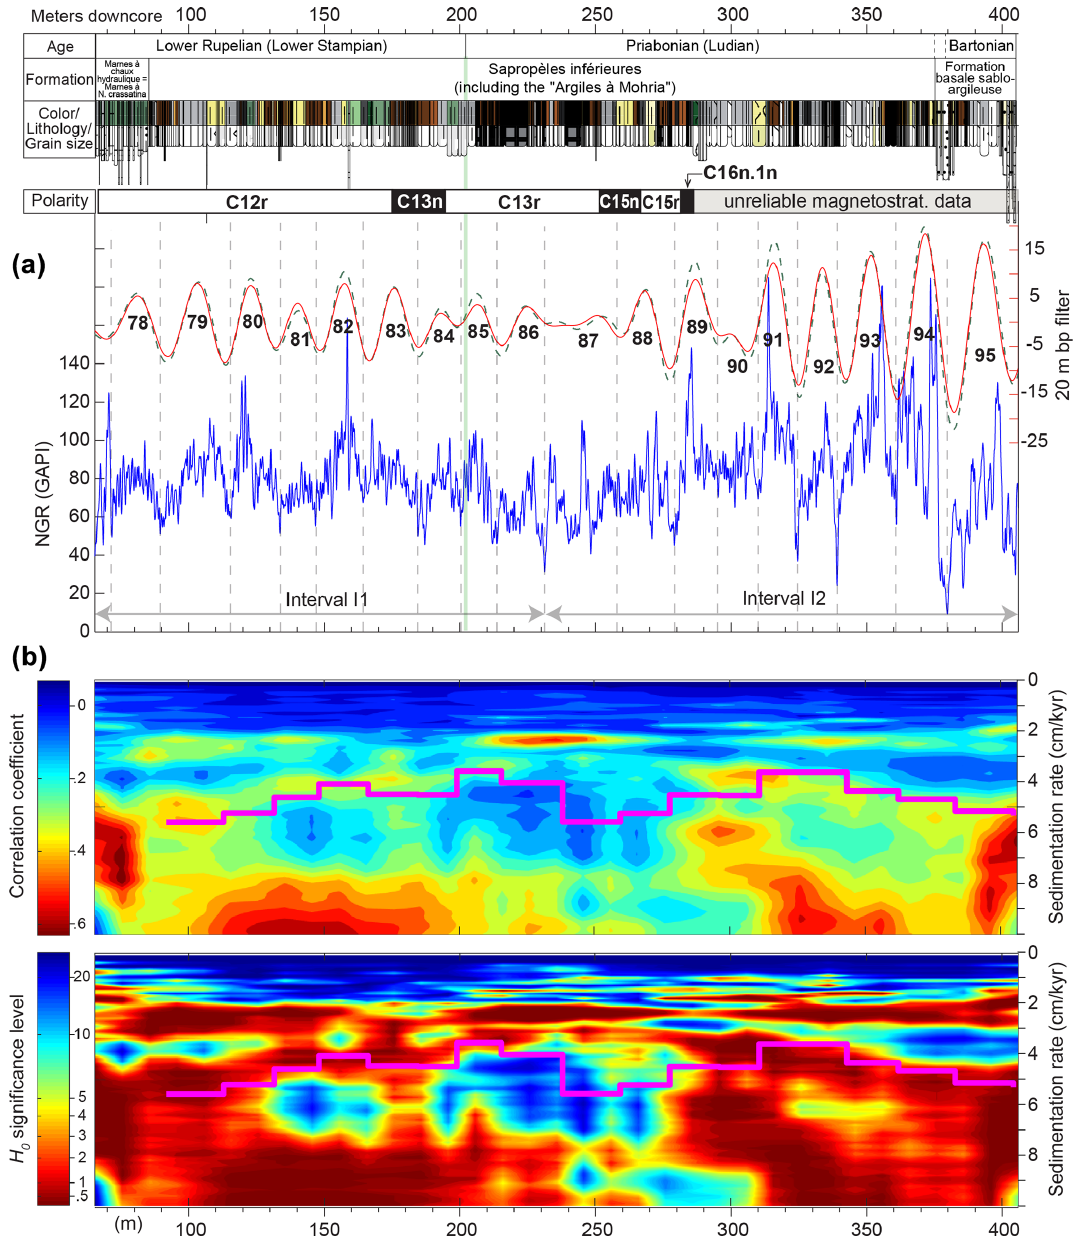
Figure 2. (a) Integrated cyclo-magnetostratigraphy of the CDB1 drill core. Paleomagnetic data are provided in the Supplement. For sediment color, lithology and grain size, see Bauer et al. (2016). On the natural gamma radiation (NGR) data (10cm resolution) a Gaussian band-pass filter (0.05 ± 0.015 cycles per meter in solid line, 0.05 ± 0.02 cycles per meter in dashed line) is applied to extract the prominent cyclicity of a ∼ 20m wavelength, interpreted as reflecting the 405kyr eccentricity periodicity. The numbering scheme for the 405kyr eccentricity cycles follows the approach of Hinnov and Hilgen (2012), where eccentricity maxima are counted back in time. Intervals I1 and I2 correspond to those used for time-series analysis in the depth domain (Fig. 3). (b) Statistical evolutive COCO outputs (see Methods). Upper panel: correlation coefficient, lower panel: null hypothesis H 0 . Stair-like curve in pink is the sedimentation rate inferred from the 405kyr tuning of the 20m wavelength shown in (a) . The eCOCO parameters are 0–10cmkyr − 1 with an increment of 0.1cmkyr − 1 for testing sedimentation rates, window = 80m, step = 1m, 1000 Monte Carlo simulations. Note that the manual sedimentation rate tracks the statistically inferred eCOCO sedimentation rate, except for the interval at roughly 240–280m, where the significance is very low. This is likely due to the poorly preserved cyclicities at the transition between 405kyr cycles 86 and 87 and cycle 88 (see Fig. 3). For the estimated optimal mean sedimentation rate over the whole studied interval, see Fig.